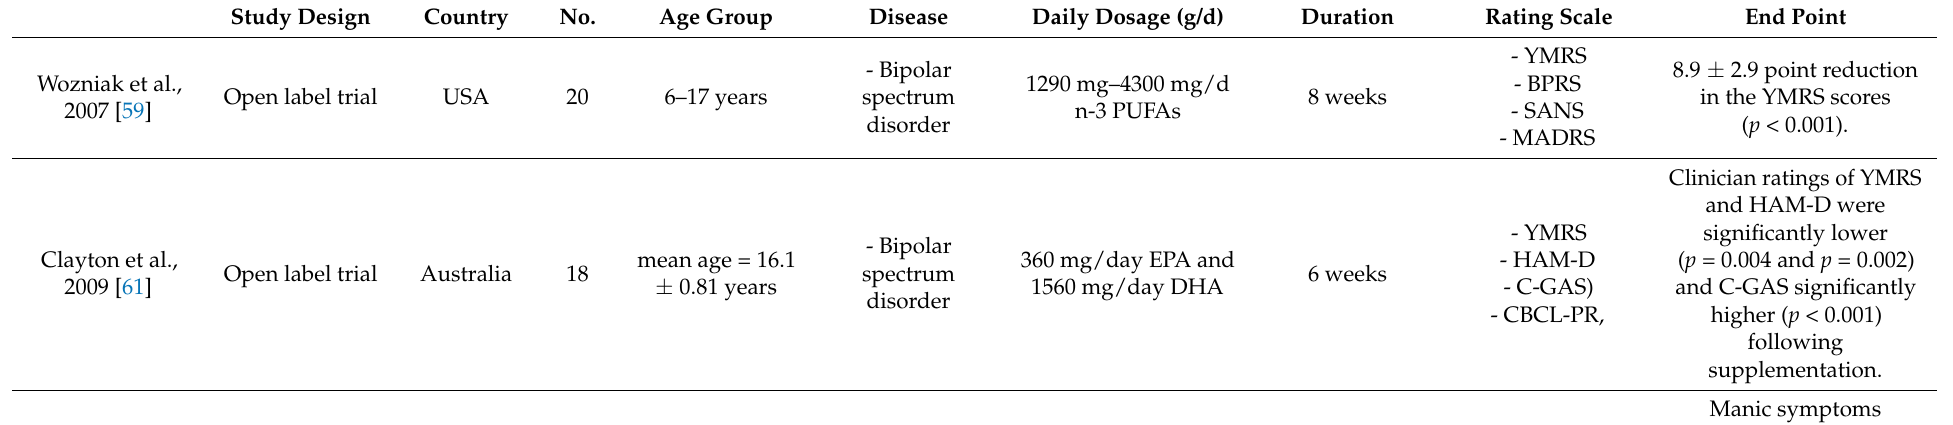
Table 2. Bipolar